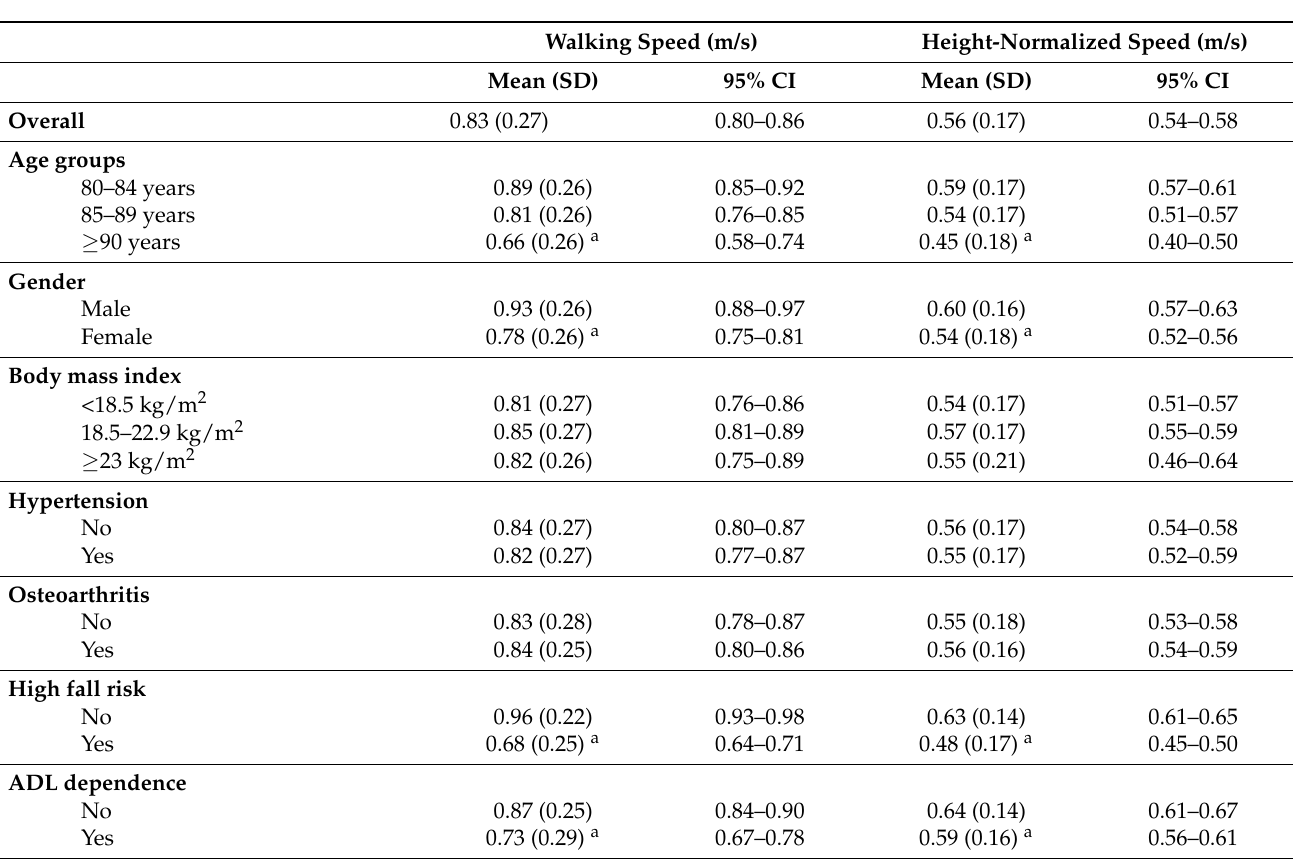
Table 2. Walking speed and height-normalized walking speed values among this study population (n =